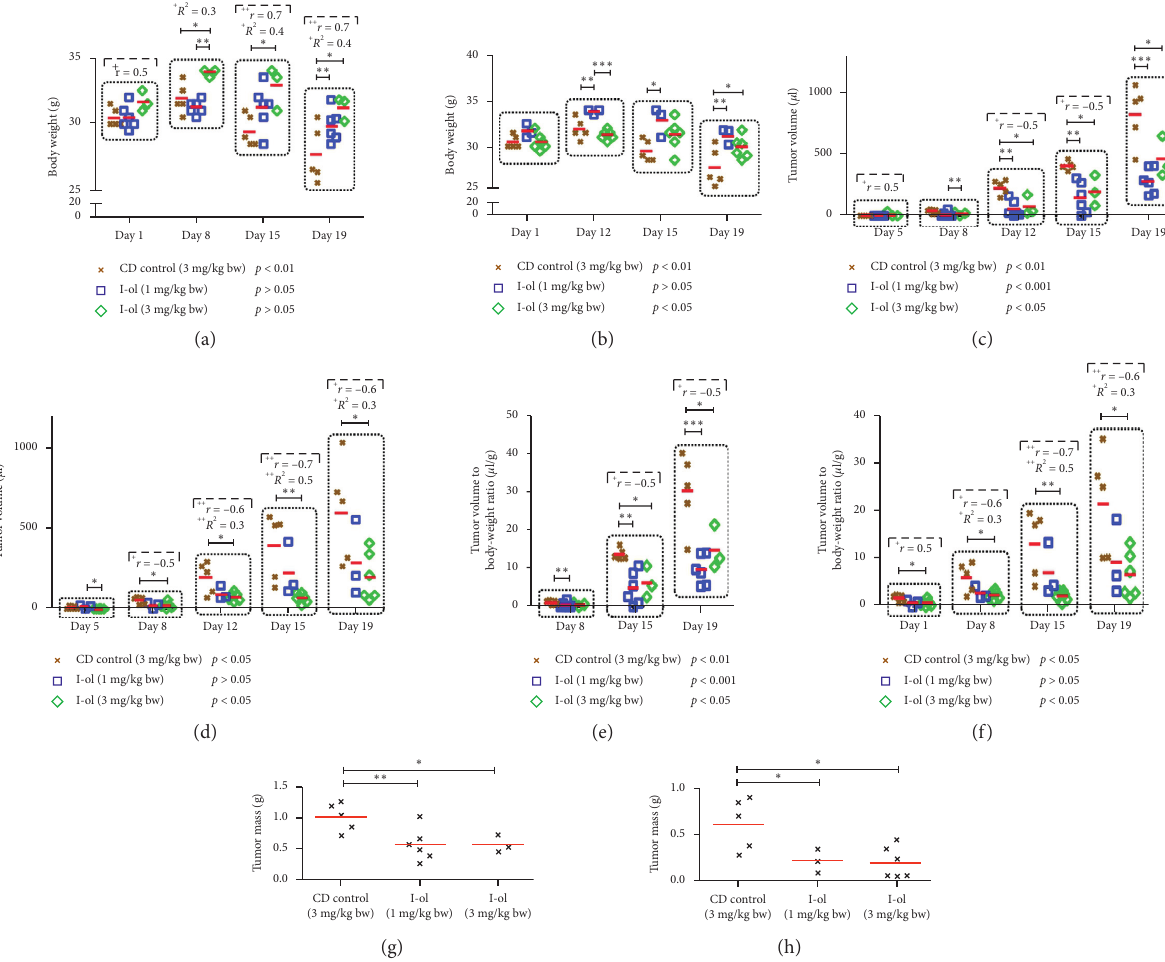
Figure 7: HepG2 cell-transplanted mice in a xenograft model. (a) Body-weight dynamics from animal study one. (b) Body-weight dynamics from animal study two. Increased body weights of the treated mice, compared to the control groups of both studies. (c) Tumour volumes from animal study one. (d) Tumour volumes from animal study two. Markedly reduced tumour volumes were observed in treated mice compared to the control groups, in both studies. (e) Tumour volume: bw ratios from animal study one. (f) Tumour volume: bw ratios from animal study two. The results are comparable to those described above. (g) Final tumour masses from animal study one. (h) Final tumour masses from animal study two. Over a two-fold decrease in the final tumour masses was observed in both studies. The significance values determined as the “simple main effect of time” are shown below the group designations. The results are depicted as individual values of the dependent variable (i.e., the measured pathological parameters) grouped around the mean value, which is depicted with a horizontal red line. Statistical calculations were performed based on two-way mixed ANOVA, followed by Bonferroni’s post hoc test. In all cases, the significance levels were ∗ p < 0 . 05 (significant), ∗∗ p < 0 . 01 (highly significant), or ∗∗∗ p < 0 . 001 (very highly significant). Dose-dependent effects of I-ol were calculated by determining Pearson’s correlation coefficient ( r ) and performing linear-regression analysis (adjusted R 2 ), with the following statistical parameters: + p < 0 . 05 (significant), ++ p < 0 . 01 (highly significant), and +++ p < 0 . 001 (very highly